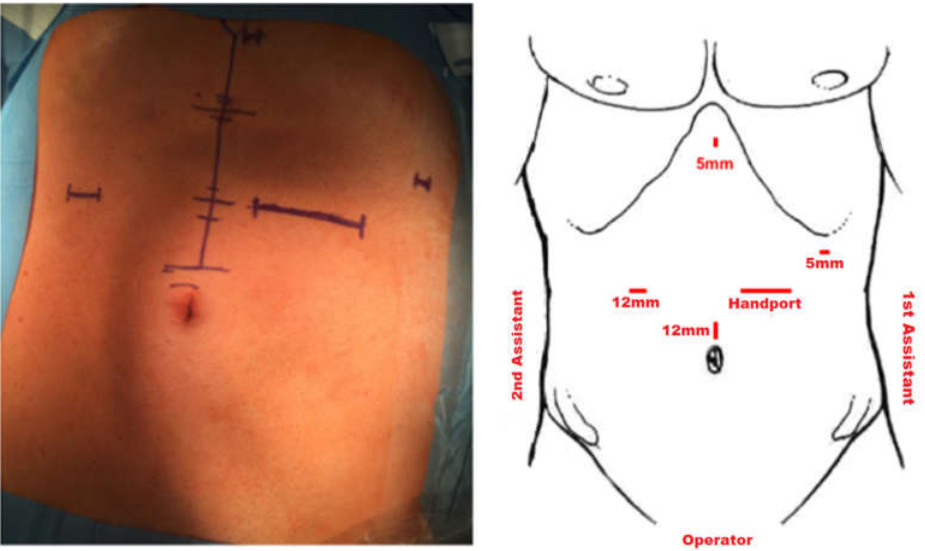
Figure 2. Trocar placement.